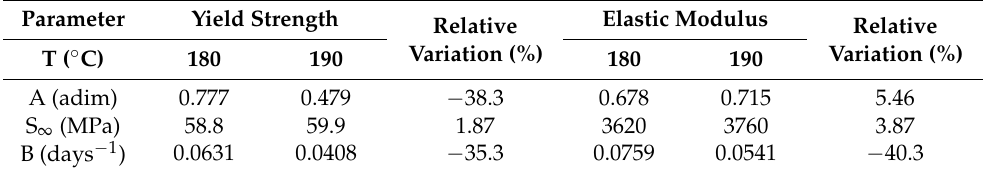
Table 3. Logistic fitting parameters and the relative variation (%) of each of them.